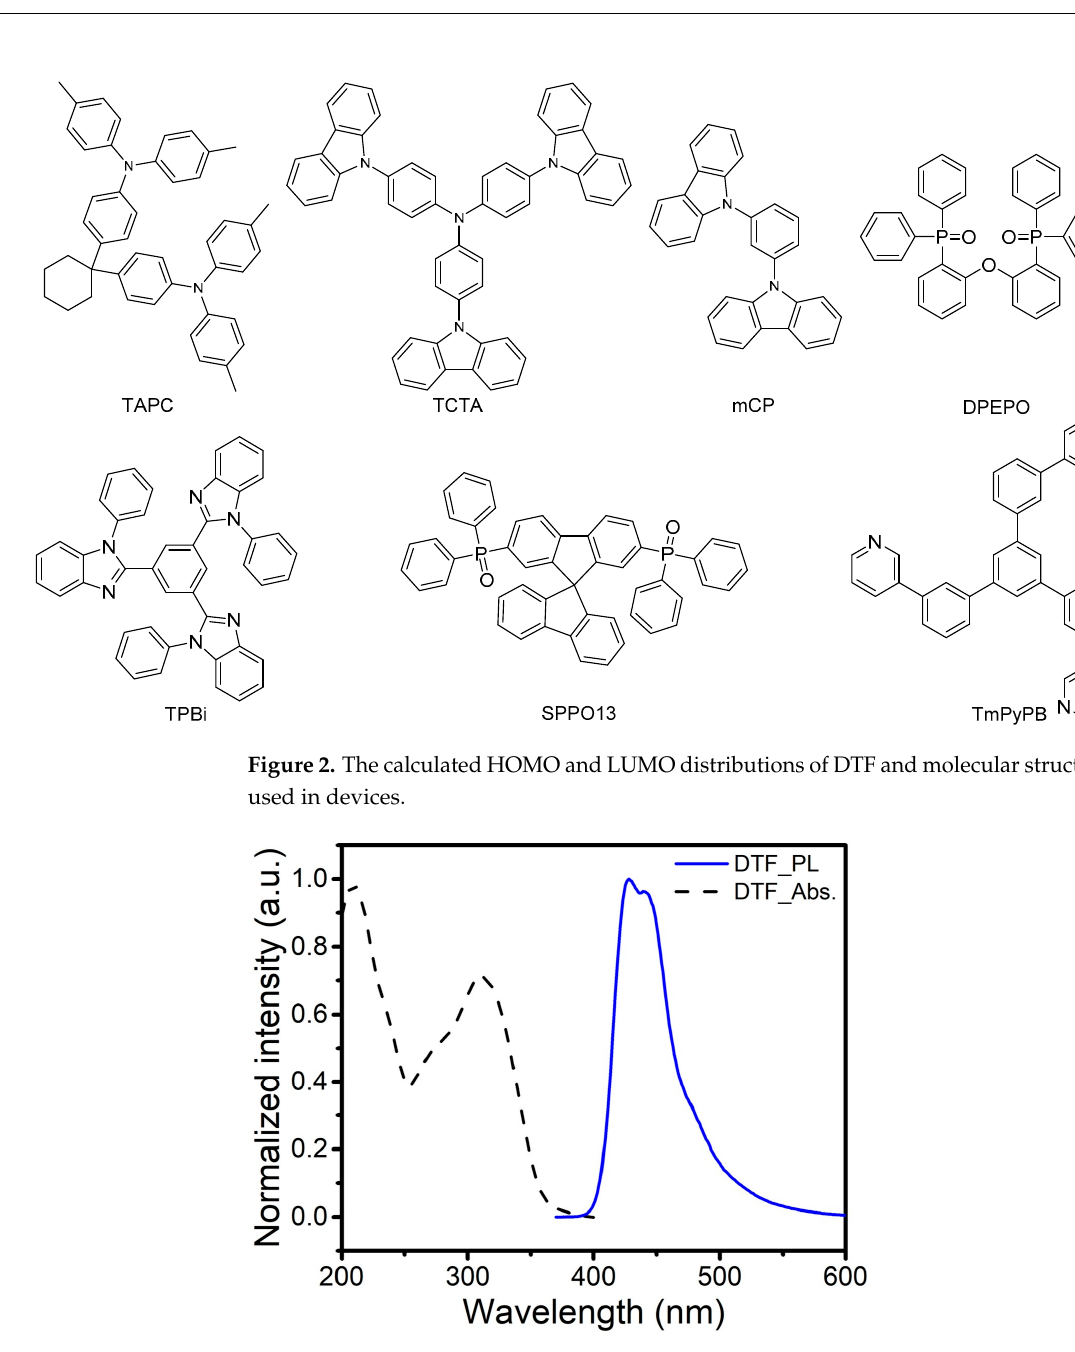
Figure 3. The ultraviolet absorption and PL spectra of DTF fi lms.